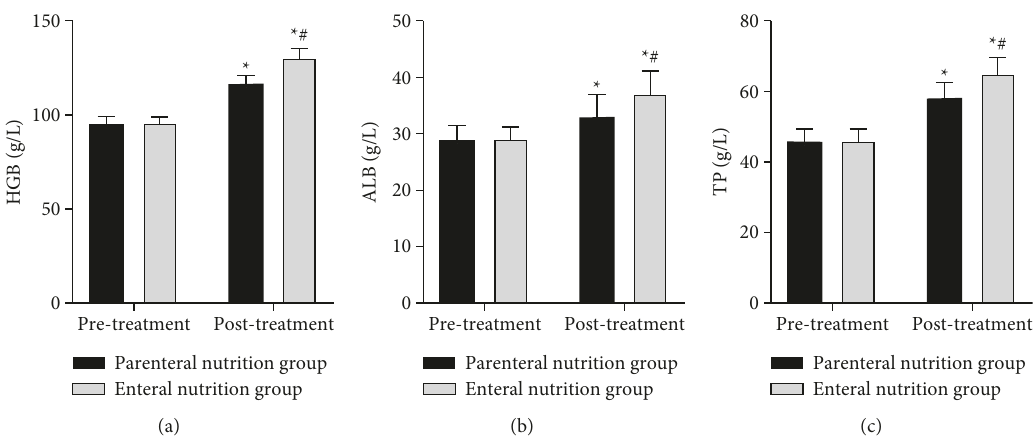
Figure 5: Comparison of nutritional status between two groups. (a) HGB level. (b) ALB level. (c) TP level. group before treatment, # comparison with the parenteral nutrition group at the same time point. There is a statistical difference.